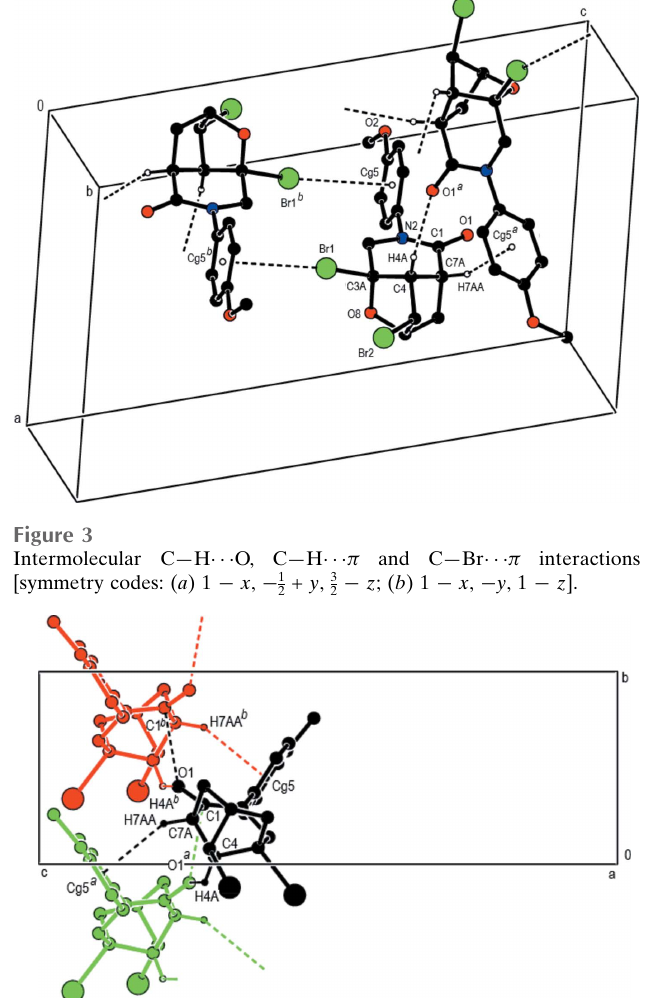
Figure 4 A fragment of the double layer in 2 formed by intermolecular C—H (cid:2)(cid:2)(cid:2) O, C (cid:2)(cid:2)(cid:2) O and C—H (cid:2)(cid:2)(cid:2) (cid:2) contacts [symmetry codes: ( a ) 1 (cid:3) x , (cid:3) 1 (cid:3) z ]. ( b ) 1 (cid:3) x , 1 + y , 3 2 2